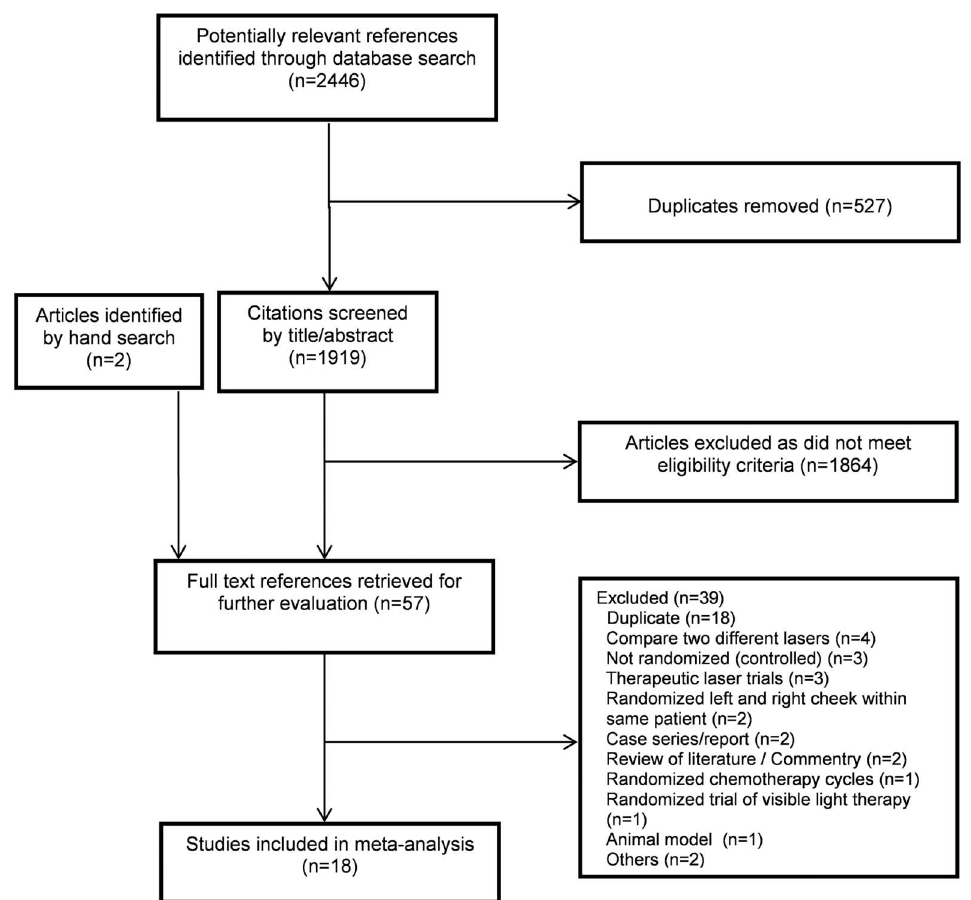
Figure 1. Flow diagram of trial identification and selection.